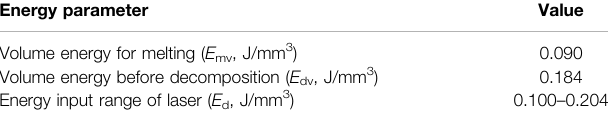
TABLE 3 | Evaluations of E mv , E dv , and E d of PCL powders. Energy parameter